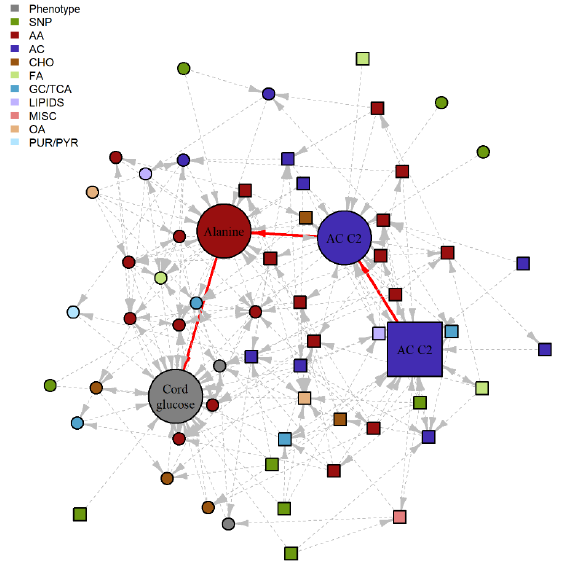
Figure 2. Subgraph of fasting BNM highlighting a potential SMM pathway. Nodes represent the metabolite, genotype and phenotype variables and edges represent the conditional dependencies between them. The maternal features are represented by square nodes and the offspring features are represented by circle nodes. Newborn outcome variables are grey, genotypes are green, and the remaining colors correspond to different metabolite classes. The solid, red edges correspond to the purported SMM pathway with statistically significant IDE after FDR correction and positive pro- portion mediated in the training data set, with nominal significance and positive PM confirmed in the validation data set. Dashed, grey edges correspond to nodes adjacent to the SMM pathway. AA, amino acid; AC, acylcarnitine; CHO, carbohydrate; FA, fatty acid; GC/TCA, glycolysis/tricarboxylic acid cycle; OA, organic acid; PUR/PYR, purine or pyrimidine.